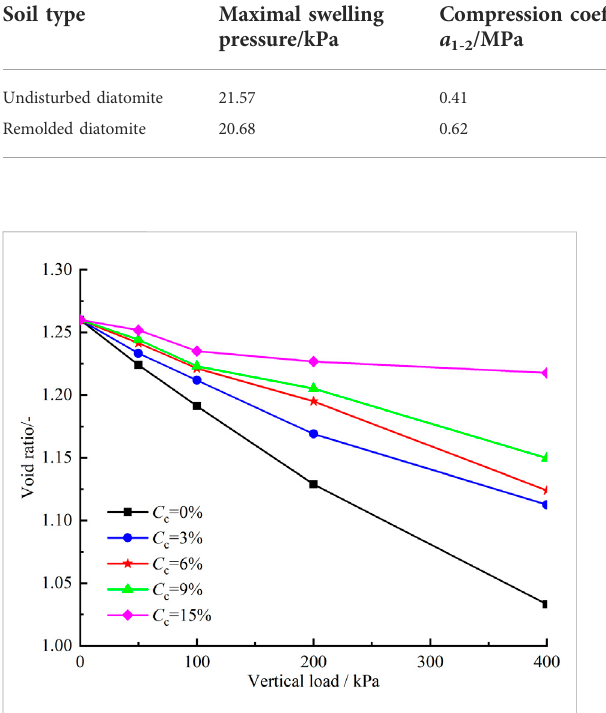
FIGURE 2 e-p curves of cement modi fi ed diatomite.